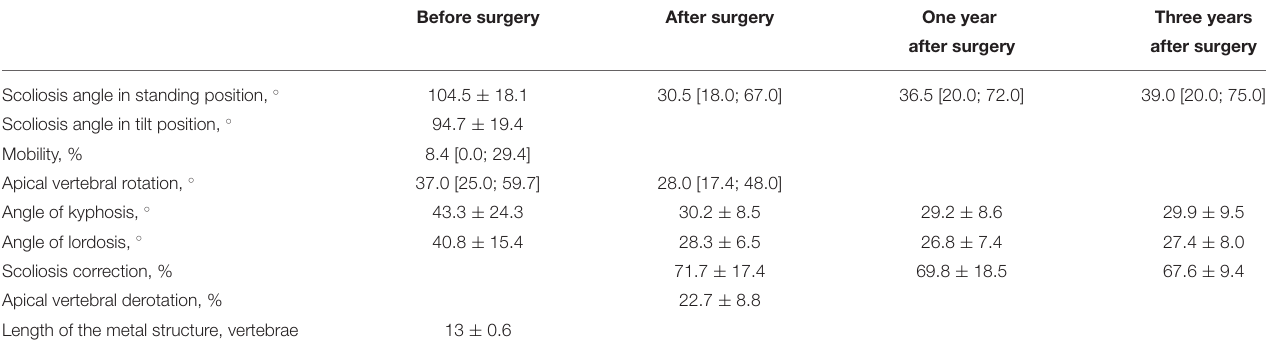
TABLE 4 | The main descriptive statistics for the indicators of the fourth group, n = 20. Before surgery After surgery One year Three years after surgery